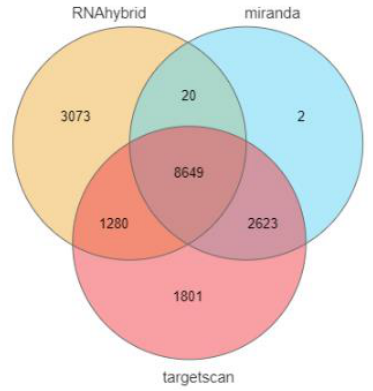
Figure 2. Target gene prediction of ssc-miR-141.